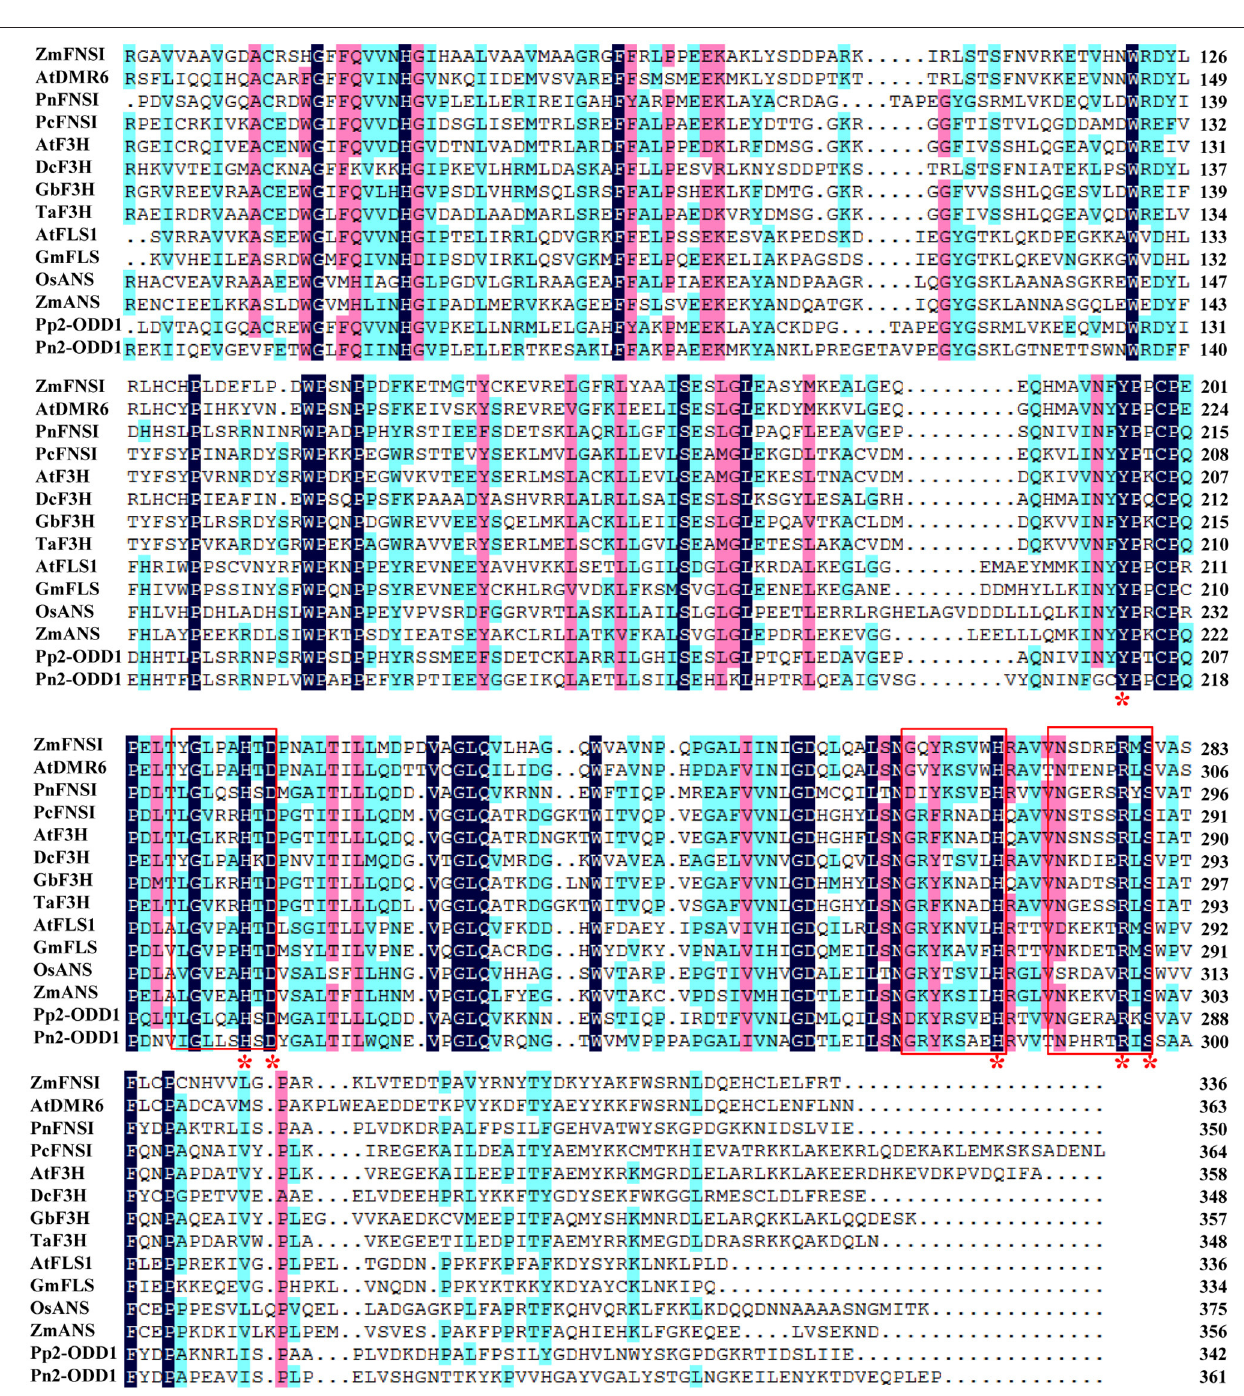
Frontiers in Plant Science |